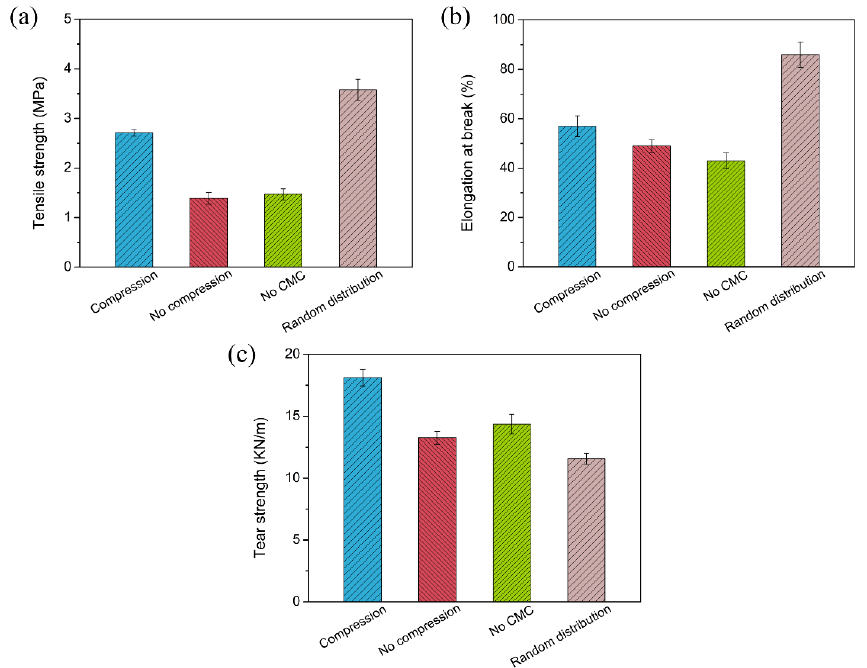
Figure 6. Comparisons of the mechanical properties of the composites at the same content of 27.5 vol% CF and 14.0 vol% alumina: ( a ) tensile strength, ( b ) elongation at break and ( c ) tear strength.